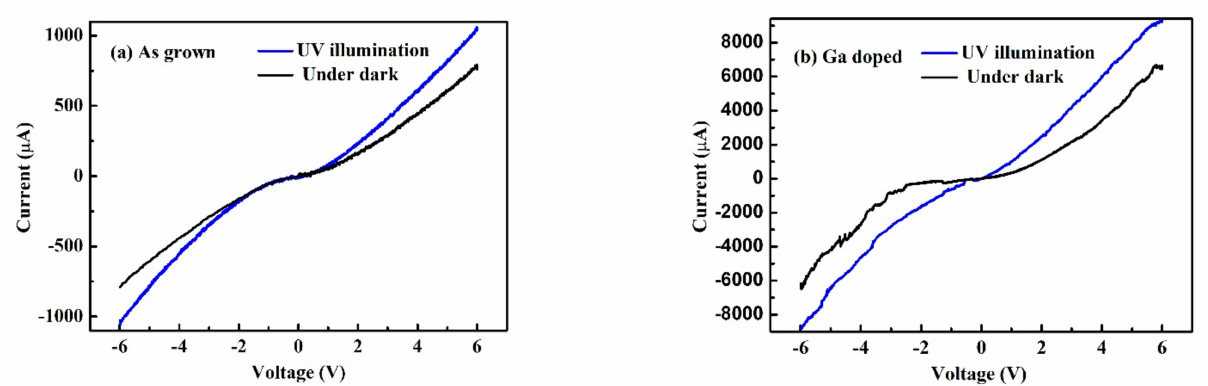
Figure 6. The current-voltage curve of the ZnMgO sample. ( a ) as grown and ( b ) with Ga dope.